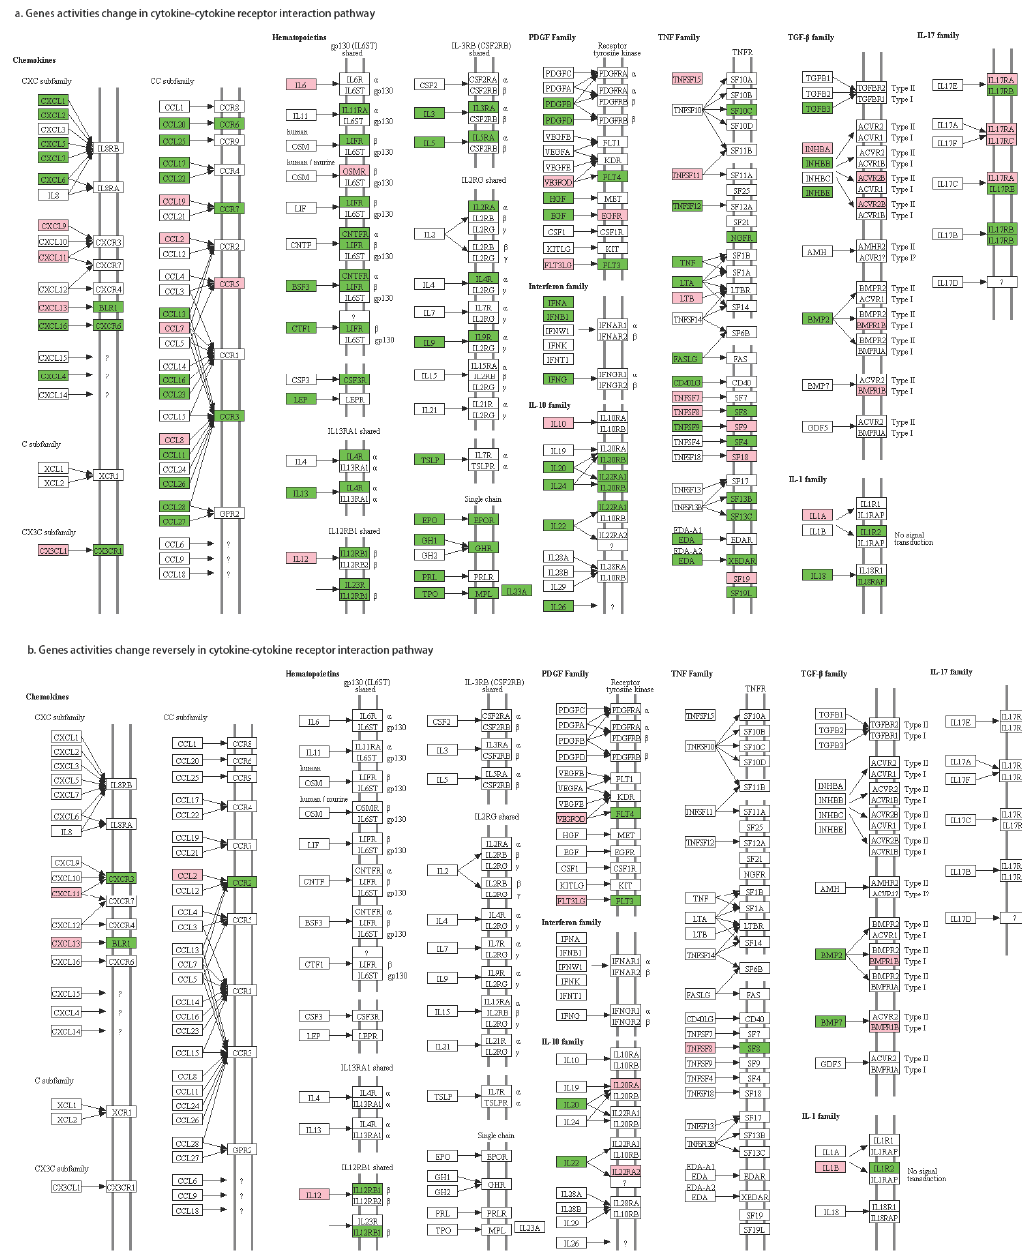
Figure 5. Gene activities in the cytokine-cytokine receptor interaction pathway.